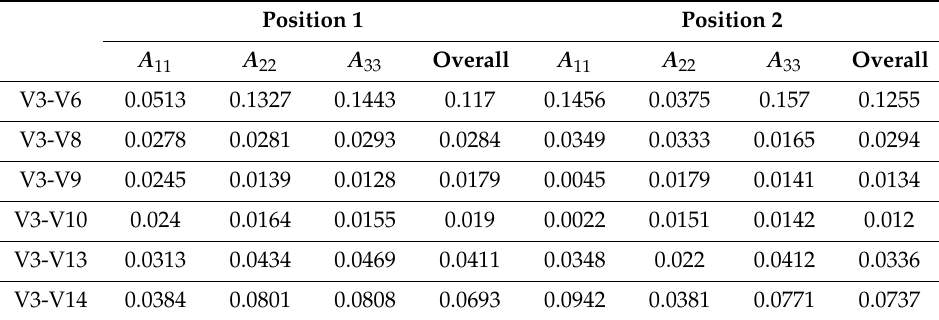
Table 4. RMSD (root mean square deviation) values with reference to V3 for A 11 , A 22 , and A 33